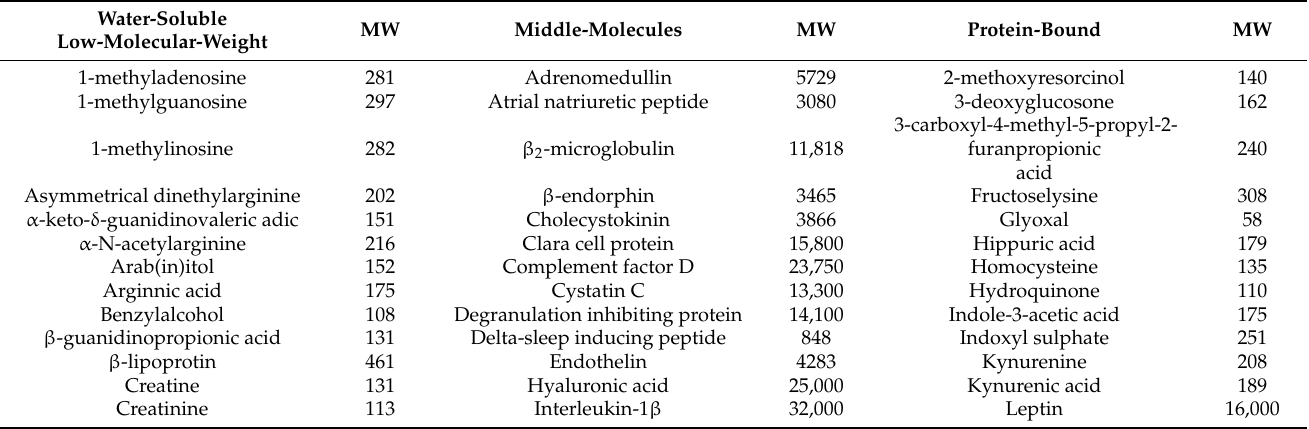
Table 1. Uremic toxins based on their physicochemical characteristic along with their molecular weight